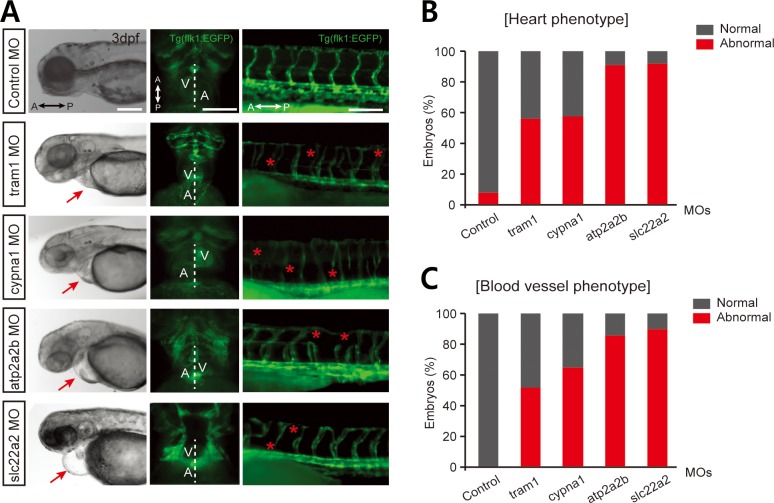
Experimental validation of novel genes for heart development in zebrafish.(A) Tg(flk1:EGFP) zebrafish embryos injected with morpholinos (MOs) for novel candidate genes for CAD showed morphological heart abnormalities, such as peripheral edema at 3 days post-fertilization (arrows in the left panel, scale bar = 500 μm). Zebrafish embryos normally have hearts with a left ventricle (V) and right atrium (A), whereas the embryos injected with MOs related to CAD genes exhibited either no asymmetry or reversed V and A orientation (middle panels, scale bar = 200 μm). These embryos also exhibited malformed blood vessels in the trunk (asterisks in the right panel, scale bar = 200 μm). (B) MO-injected Tg(flk1:EGFP) zebrafish embryos were counted to quantify those that exhibited heart asymmetry. (C) MO-injected Tg(flk1:EGFP) zebrafish embryos were counted to quantify those that exhibited vascular defects. Over 20 MO-injected embryos per gene were counted for each analysis (A-C).